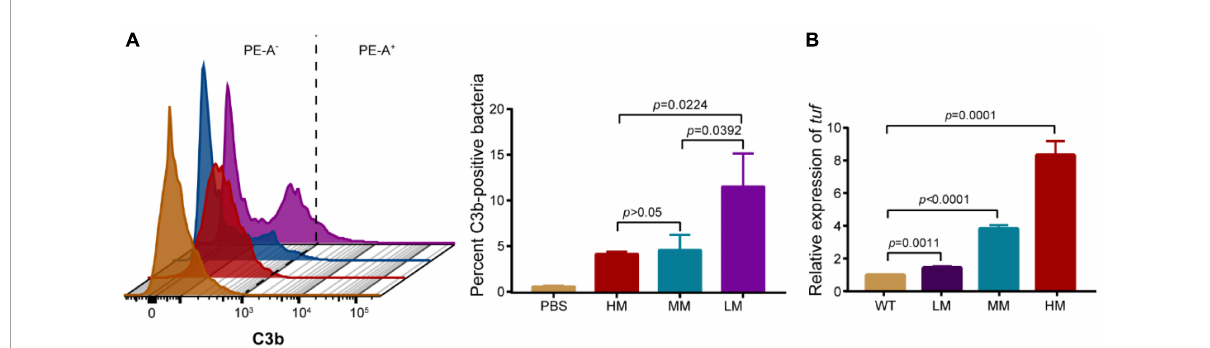
FIGURE4 Hypermucoviscous A. baumannii reduces C3b deposition. (A) Representative histograms of anti-C3b fluorescence in A. baumannii (left) . Quantitative analysis of C3b-positive bacteria (right) . PE-A as the anti-C3b fluorophore. 10,000 events were collected per condition for flow cytometry, gated for singlets via FSC/SSC, fluorescence gate set to exclude 99% of isotype control and copied across samples ran in parallel. (B) The mRNA expression of translation elongation factor tuf in WT and mucoid A. baumannii . All experiments were performed as three biologically independent experiments, and the mean ± SD was shown. P values were determined using an unpaired, two-tailed Student’s t